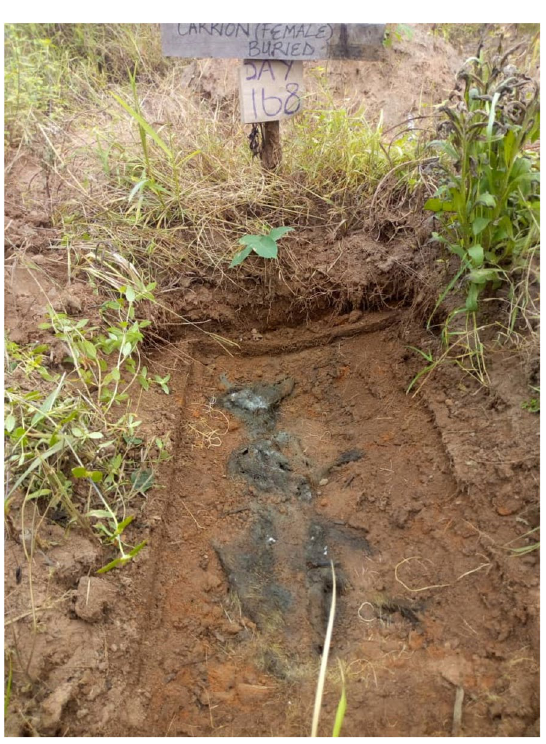
Fig. 10 Day 168 — late advanced decay stage/early skeletonization